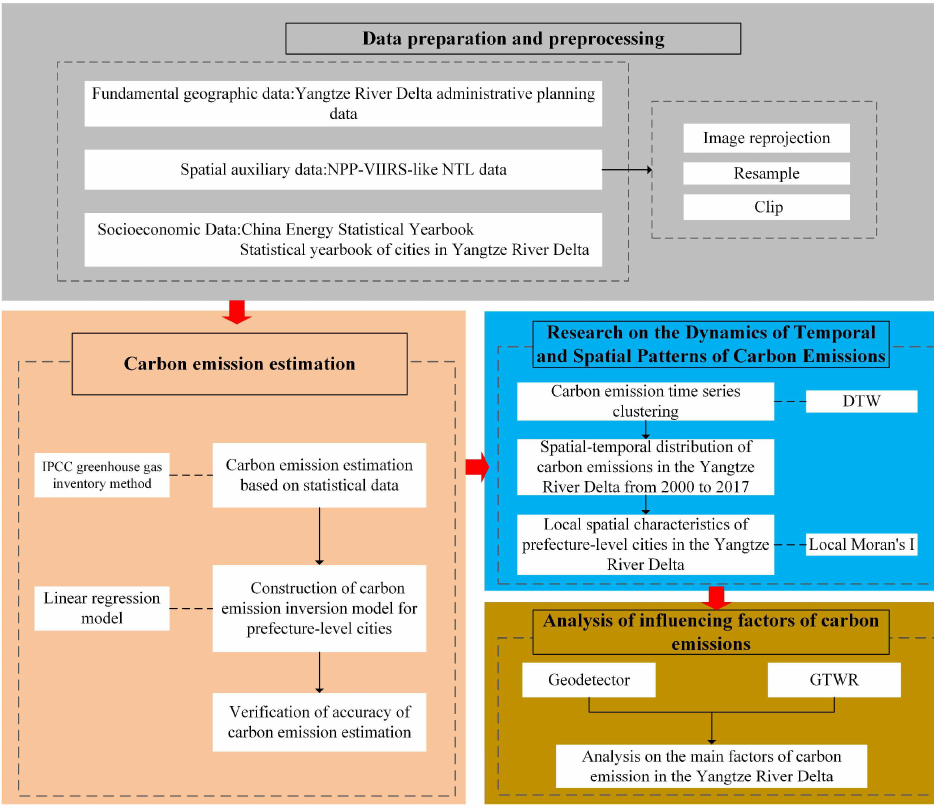
Figure 3. Technology roadmap.